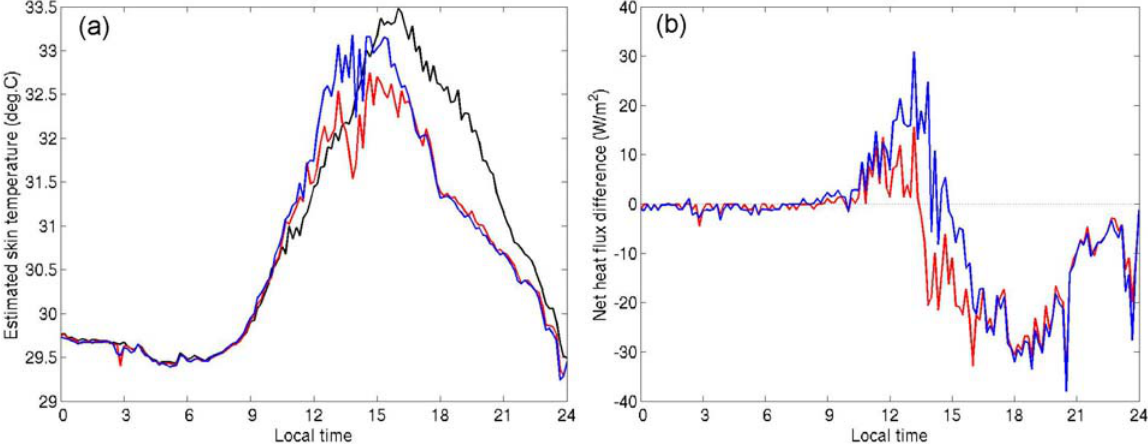
Figure 8. (a) Skin temperatures (SST ) estimated from the 0.2-m-depth mark-side skin temperature (blue), from the 0.2-m-depth opposite-side temperature (red), and from the 1.5-m-depth CT temperature (black) using the warm-layer and cool-skin models [10] on 16 May 2006. Temperature data from 0.2 m were re-sampled every 10 minutes. (b) Differences between the net heat flux estimated from the 0.2-m-depth mark-side temperature and that from the CT temperature (blue), and between the net heat flux estimated from the 0.2-m-depth opposite-side temperature and that from the CT temperature (red) on 16 May 2006.